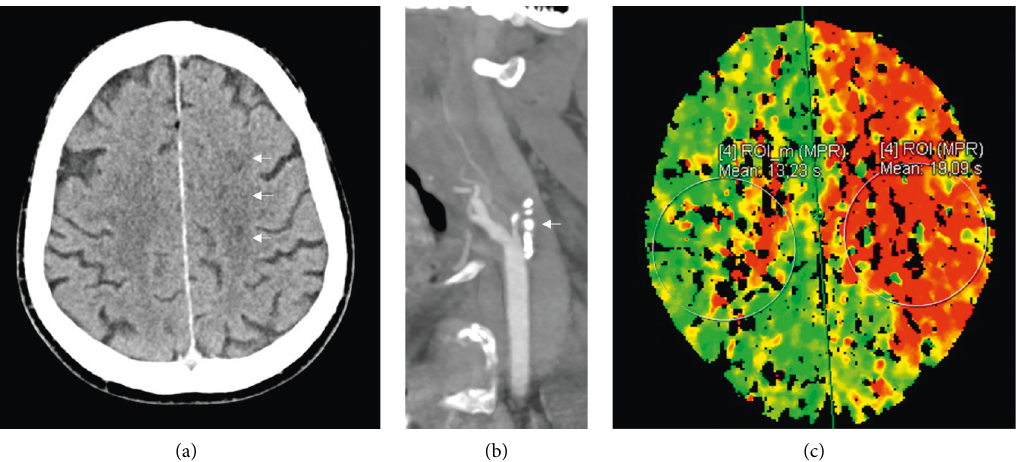
Figure 1: (a) Noncontrast CT: small border zone infarcts (white arrows) ASPECTS 10. (b) CT angiography: occlusion of the left ICA caused by a preexisting atherosclerotic stenosis (white arrow). (c) Time-to-peak map of CT perfusion: delay in maximum attenuation of 5.7